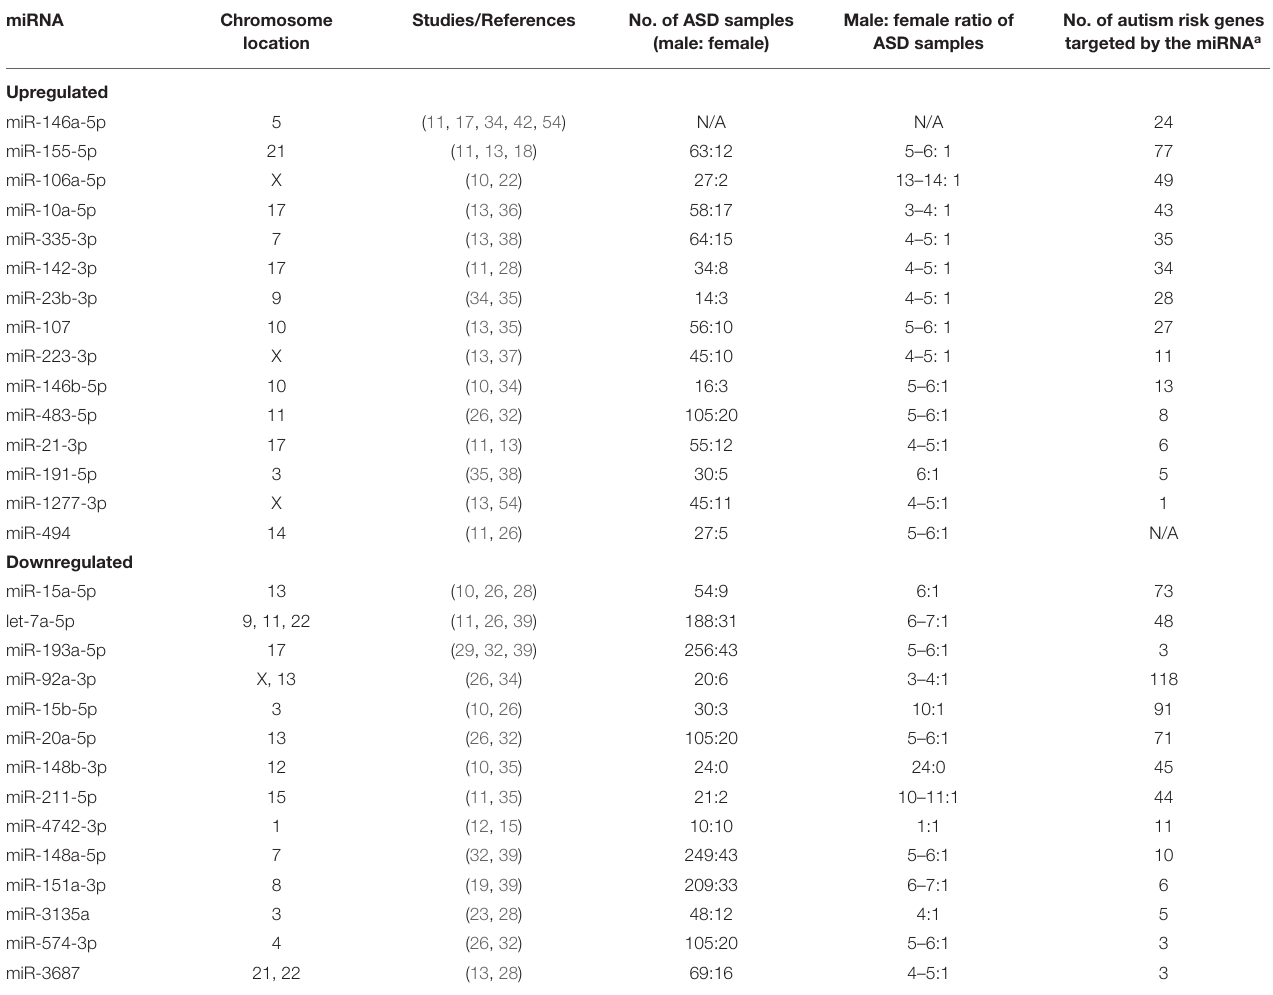
TABLE 1 | Consistently dysregulated miRNAs reported in at least two expression profiling studies. miRNA Chromosome